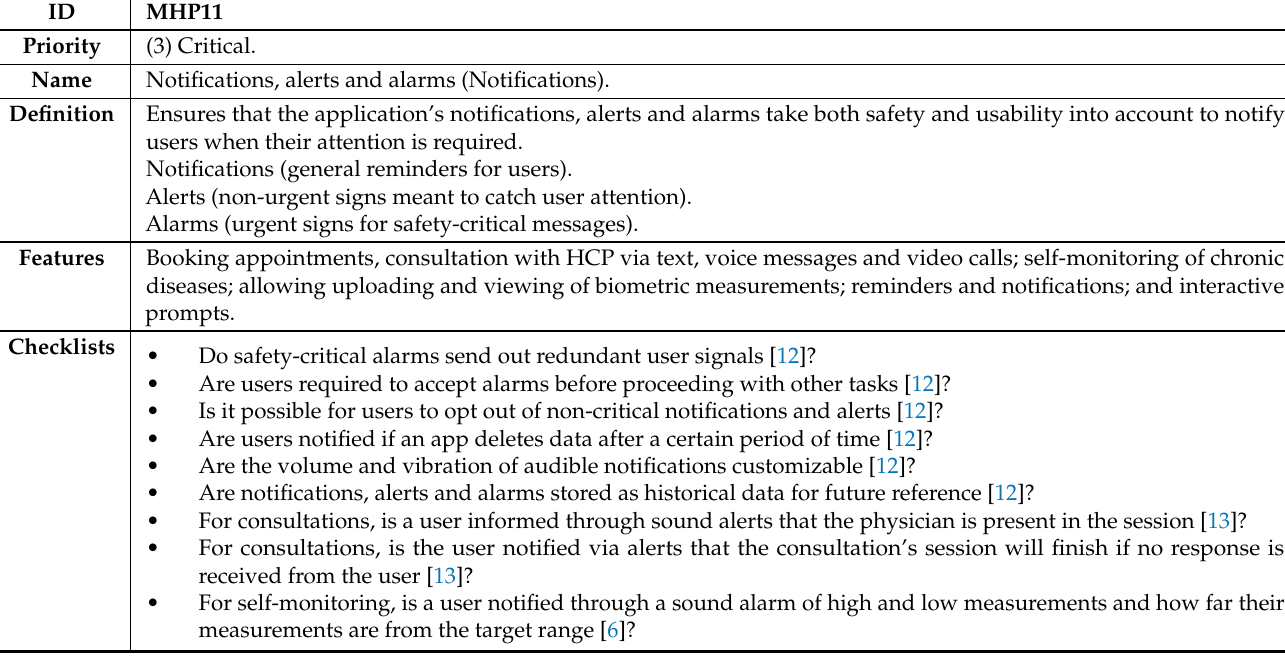
Table A12. Descriptive details of the twelfth